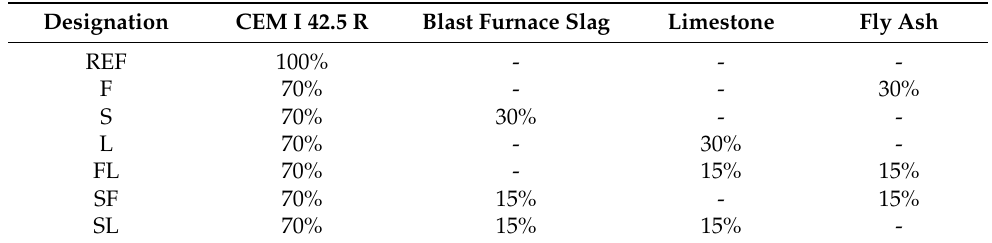
Table 1. Designation of the mortars prepared and percentage (in weight) of the binder components.